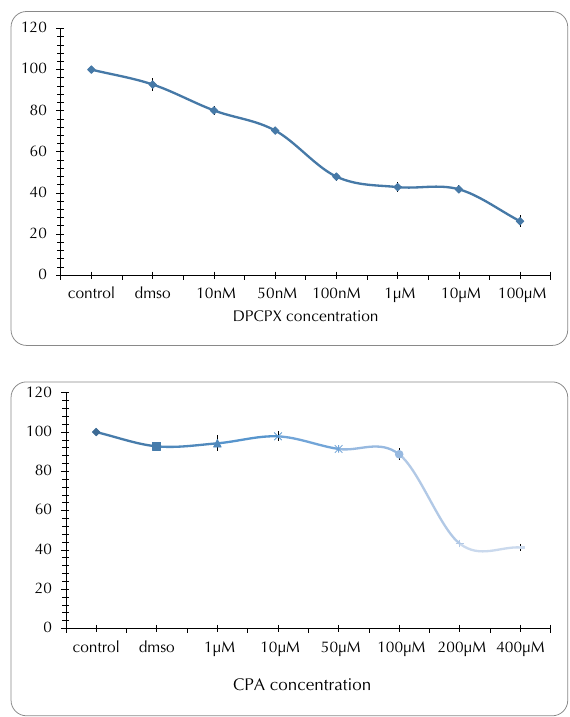
Figure 1. IC50 Assay for Calculating the Half-maximal Inhibitory Concentration of CPA and DPCPX in T47D Breast Cancer Cells. Note . Each group of cells treated with/without the agonist and antagonist in indicated concentrations and the relative amount of viable cells were estimated by measuring Formosan crystal formation and then light attraction. The graph percentage of cell viability versus each dose of CPA or DPCPX was used to calculate IC50 values.